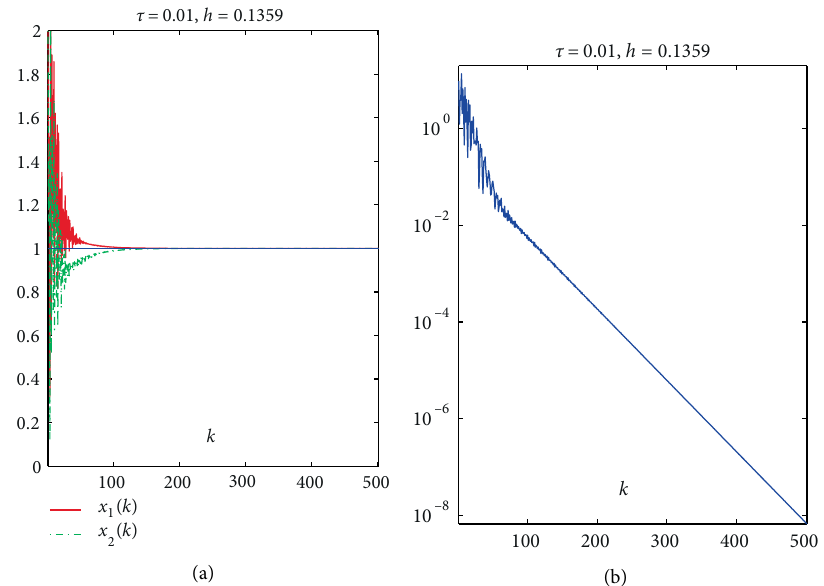
Figure 1: Trajectories generated by NDTZNN. (a) State trajectories with 𝑡 = 𝑡